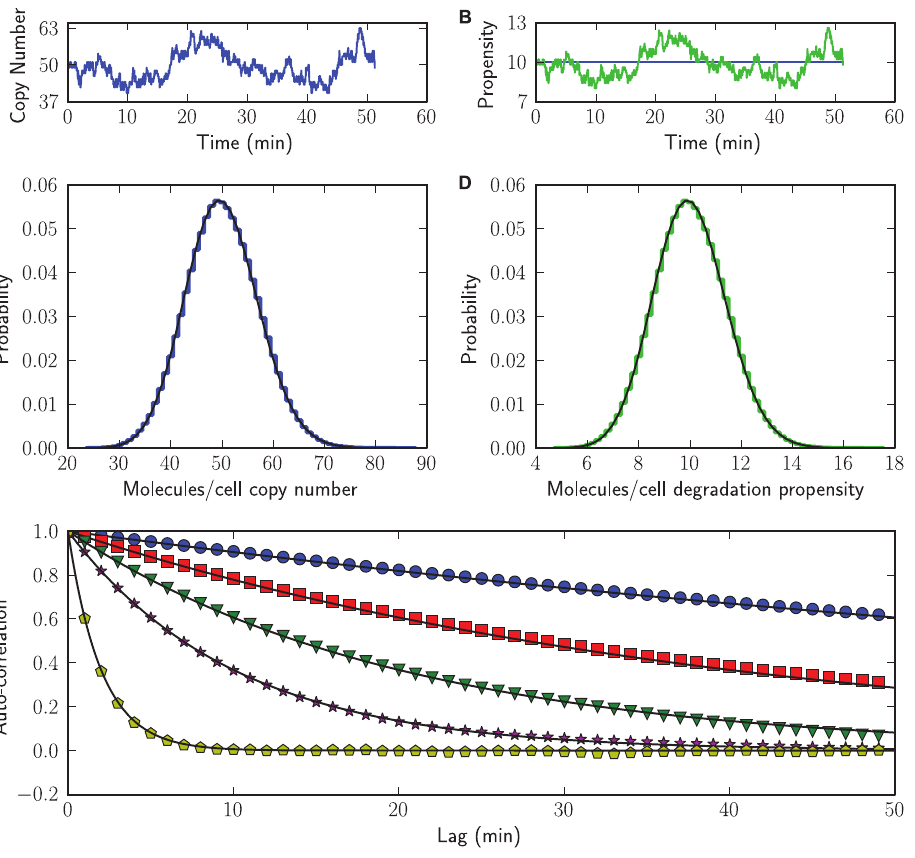
Figure 3. Propensities and auto-correlations. Illustration of several plotting options in StochPy. Colored lines represent StochPy output and black the analytical solutions. (A) species time-series data. (B) propensities time-series data. (C) species distribution. (D) propensities distribution. (E) auto-correlation for different k deg values (0.01, 0.025, 0.05, 0.1, 0.5).